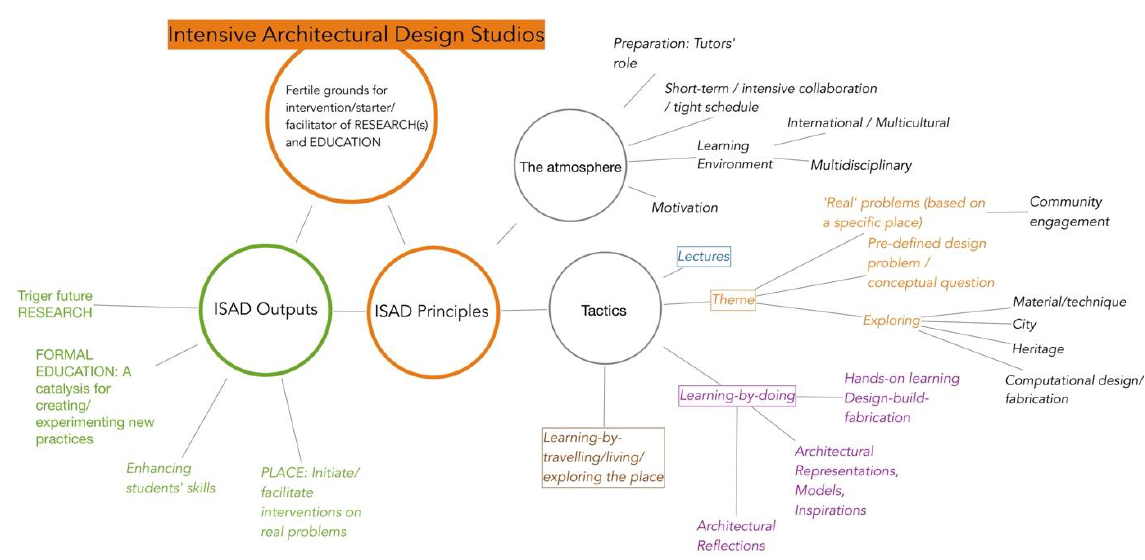
Figure 2 Representation of the relationships among emerging themes and